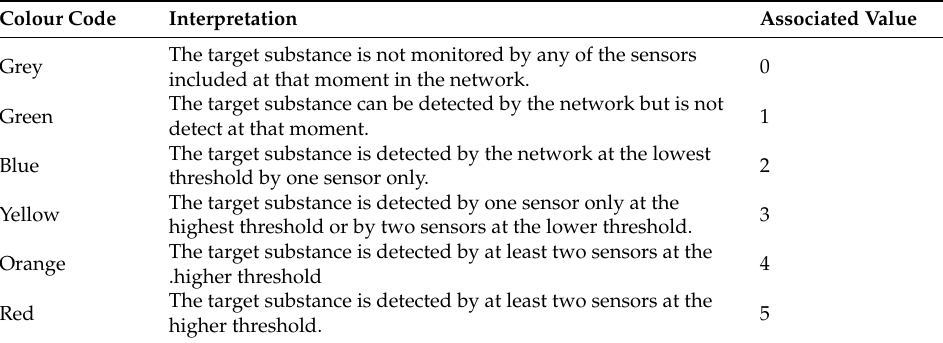
Table 7. Interpretation of the colour code used to represent the Step 2 output. Colour Code Interpretation Associated